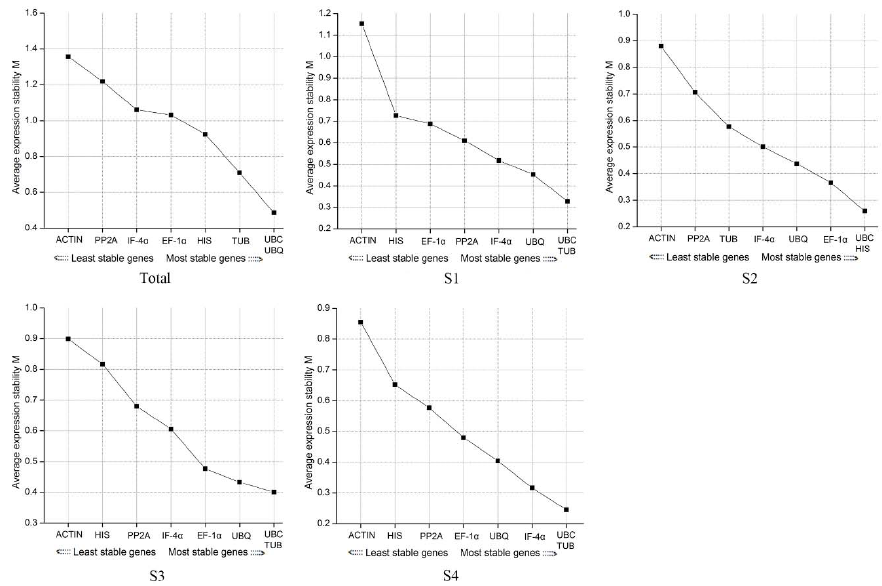
Figure 4. The M ‐ values of the eight genes in different development stages. M : Average stability Figure 4. The M -values of the eight genes in di ff erent development stages. M : Average stability index.